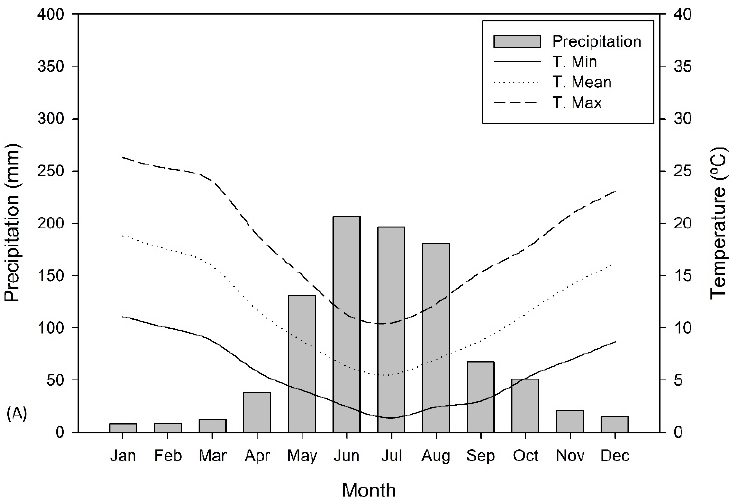
Table 1. Vegetation cover and geomorphological data of surface (ha), exposure (°) and slope (°) in the catchments. Figure 2. Cont